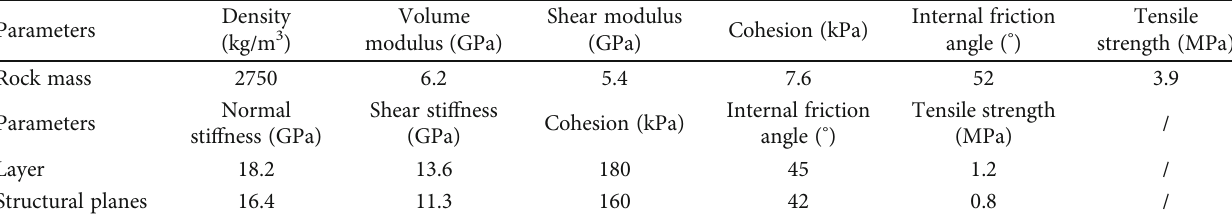
Table 2: Parameters of materials in nonfreeze-thaw area (area II).